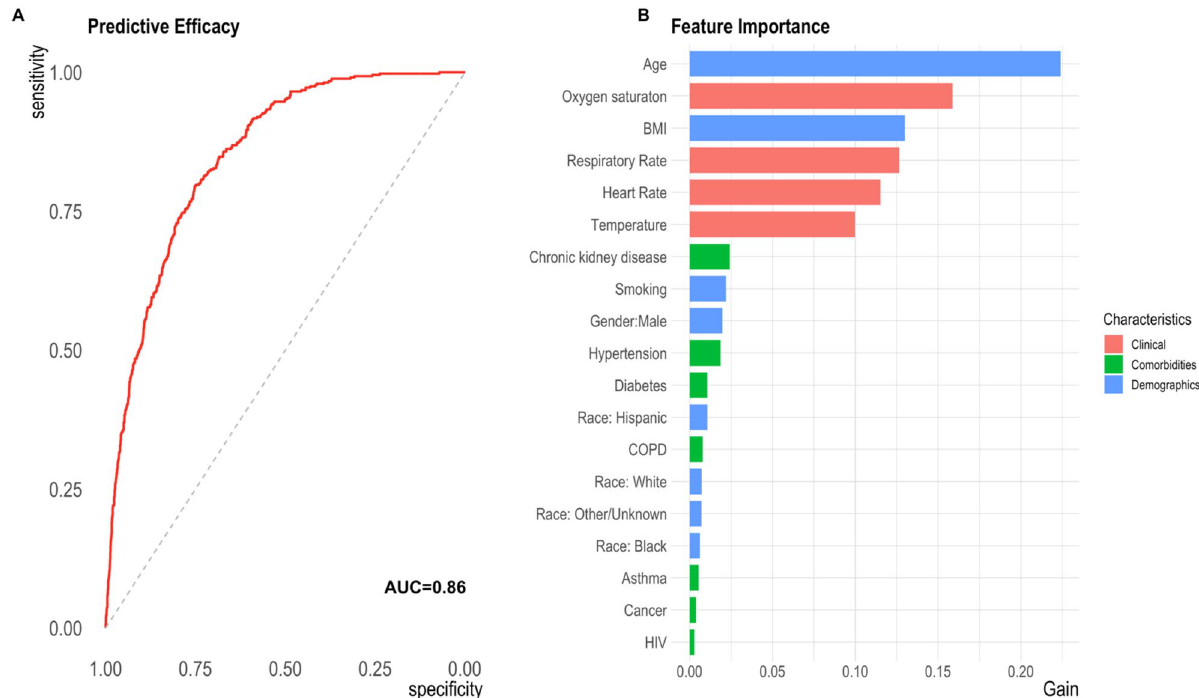
Figure 2. Predictive classification of COVID-19 mortality. A Receiver operating characteristic (ROC) curve illustrating the sensitivity and specificity for predicting COVID-19 mortality using a gradient boosting algorithm. B Importance of each feature to COVID-19 mortality prediction. Features are color coded to indicate the group of characteristics. BMI body mass index, COPD chronic obstructive pulmonary disease, HIV human immunodeficiency virus. Clinical factors were assessed at the first